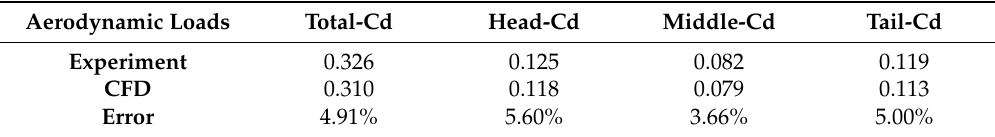
Table 3. Comparison of aerodynamic coefficients between experimental results and numerical results. Aerodynamic